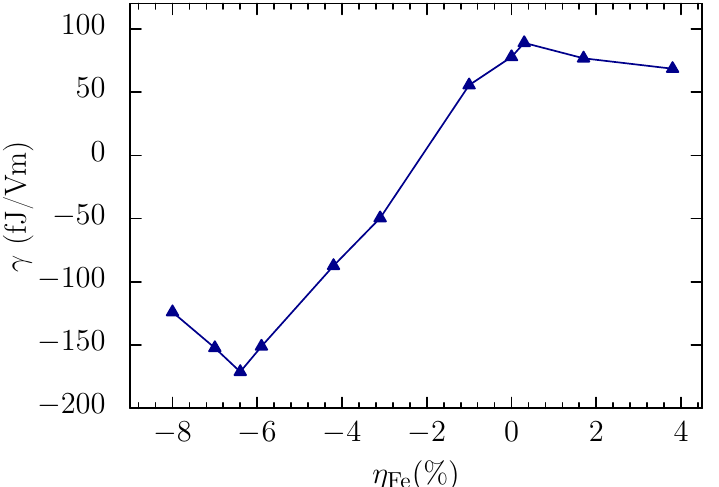
5.9% and ( b ) MCAE as electric field (EF) − 5.9%. −